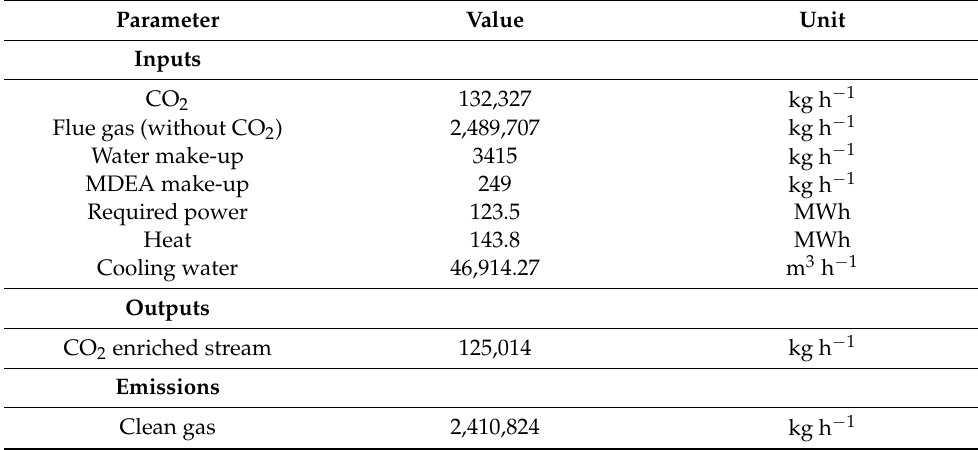
Table 5. Inventory of the carbon capture unit.